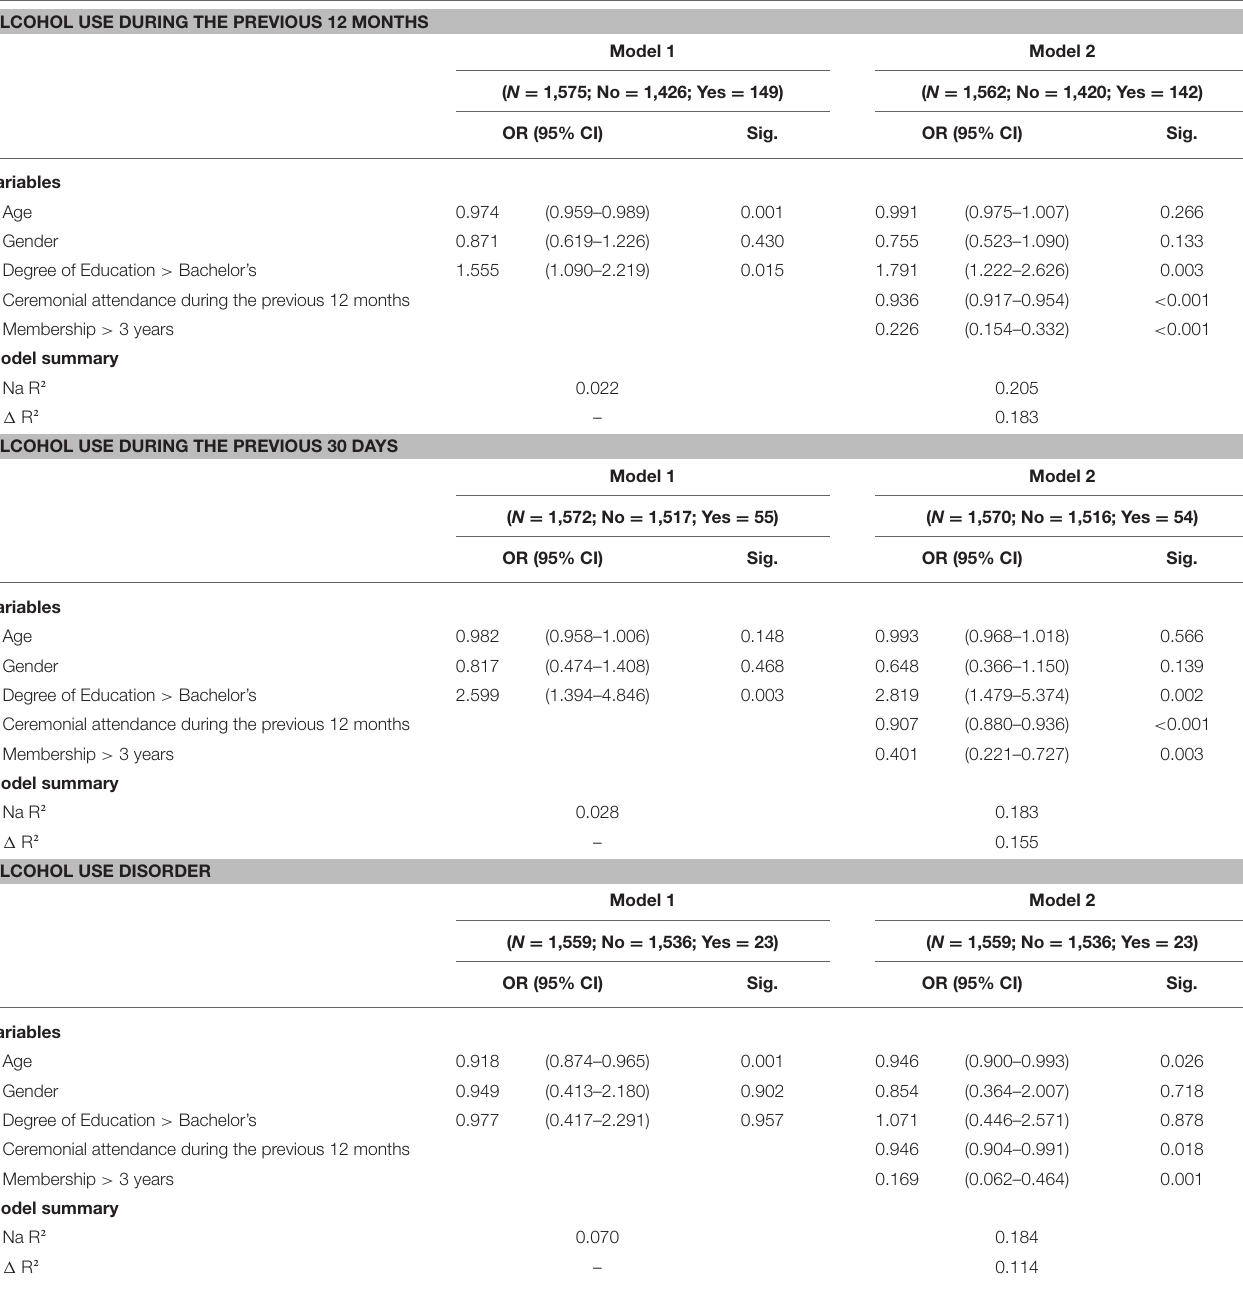
TABLE 5 | Hierarchical logistic regressions for alcohol